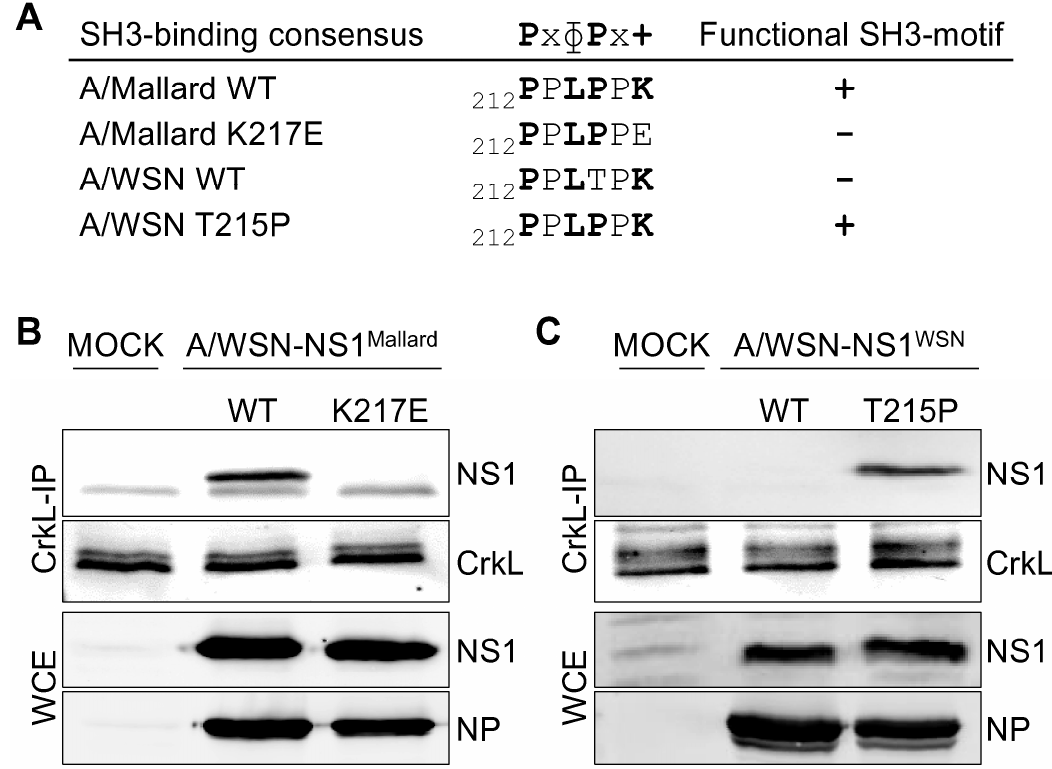
Figure 1. A functional SH3 binding motif in the non-structural protein-1 (NS1) is required for interaction with Crk-like adapter protein (CrkL) in influenza A virus (IAV)-infected cells. ( A ) The consensus sequence of class II SH3 binding motif, and its presence ( + ) or absence ( ´ ) in the C-terminal region (residues 212–217 shown) of NS1 proteins of the recombinant IAV strains used in this study. In SH3 binding consensus x indicates any residue, F a hydrophopic residue, and + a positively charged amino acid, which for Crk-family SH3 domains is preferable a lysine residue; ( B,C ) Co-immunoprecipation of NS1 proteins with CrkL from lysates of A549 cells infected with recombinant A/WSN-based IAV strains expressing wild-type or mutant NS1 proteins derived from A/Mallard ( B ) or A/WSN ( C ) for 24 h at a multiplicity of infections (MOI) 2. Note that these NS1 proteins naturally differ in their SH3 binding capacity, and the mutations introduced in them thus have opposite effects. NS1 and nucleoprotein ( NP ) blots from whole cell extracts ( WCE ) before anti-CrkL immunoprecipitation are shown to control equal infection of the cells by the different